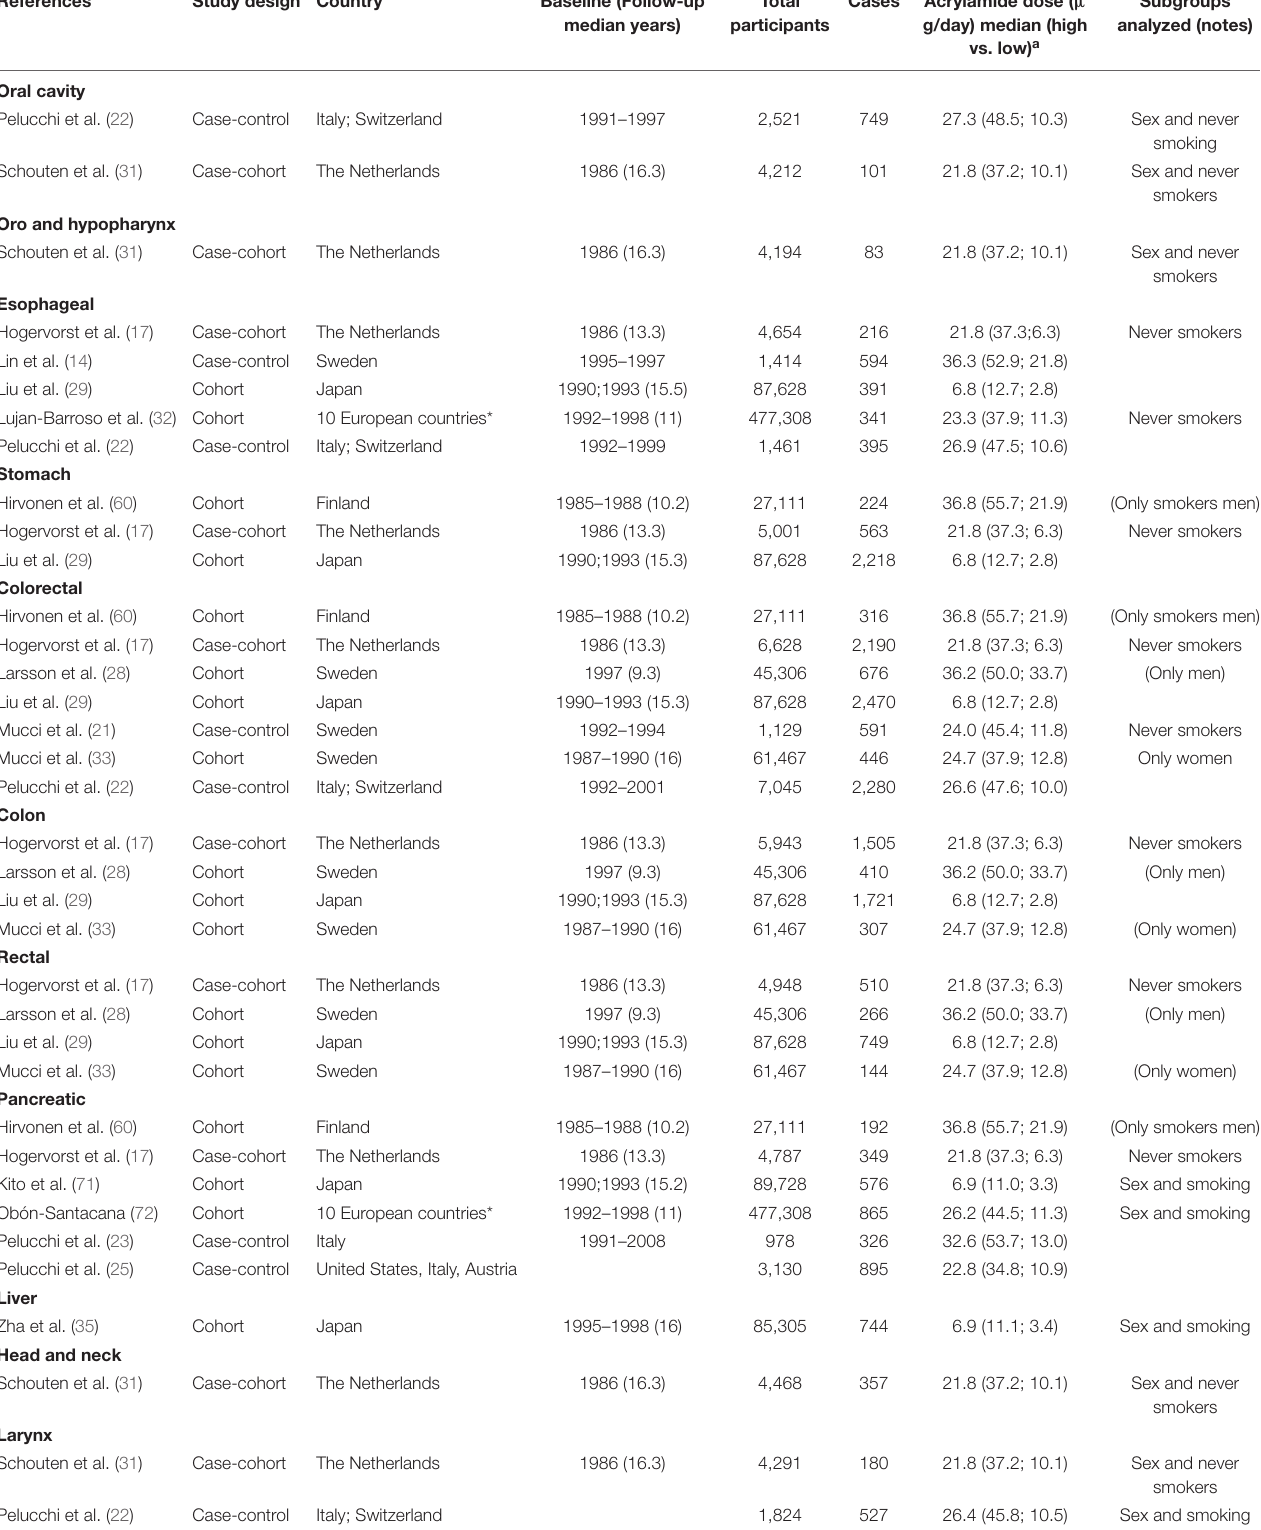
TABLE 1 | Descriptive characteristics of the included studies by site-specific